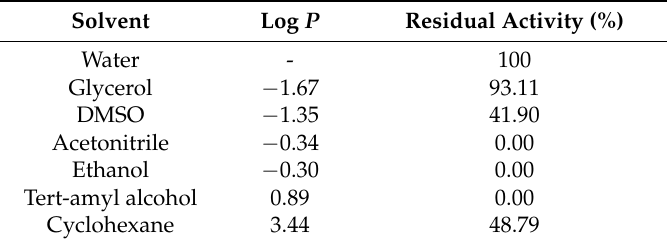
Table 3. Stability of the Penicillium sp. (CBMAI 1583) lipase octyl derivative (Oct) in organic media.